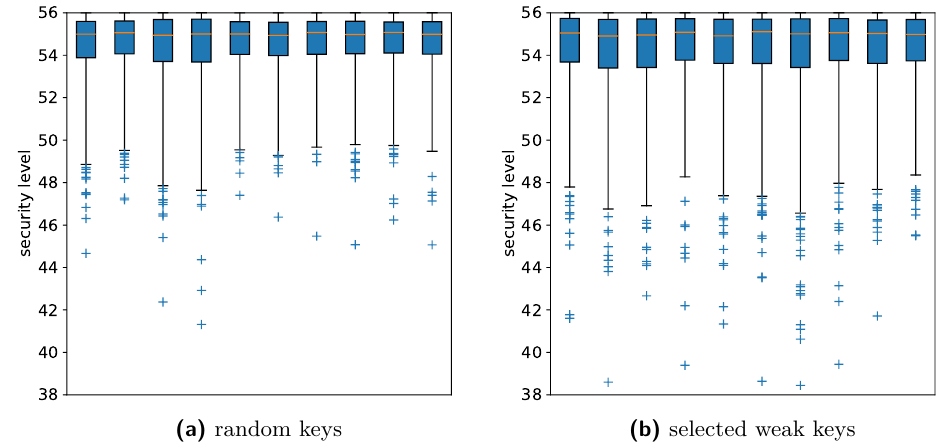
Figure 16: Box plot of resulting security levels from 900 single trace attacks for ten randomly selected keys on the left and ten weak keys on the right. The interquartile range (IQR) is shown as solid blue boxes, the 1 . 5-times IQR range as line with ending, and the outliers are marked as a +. The median is marked in